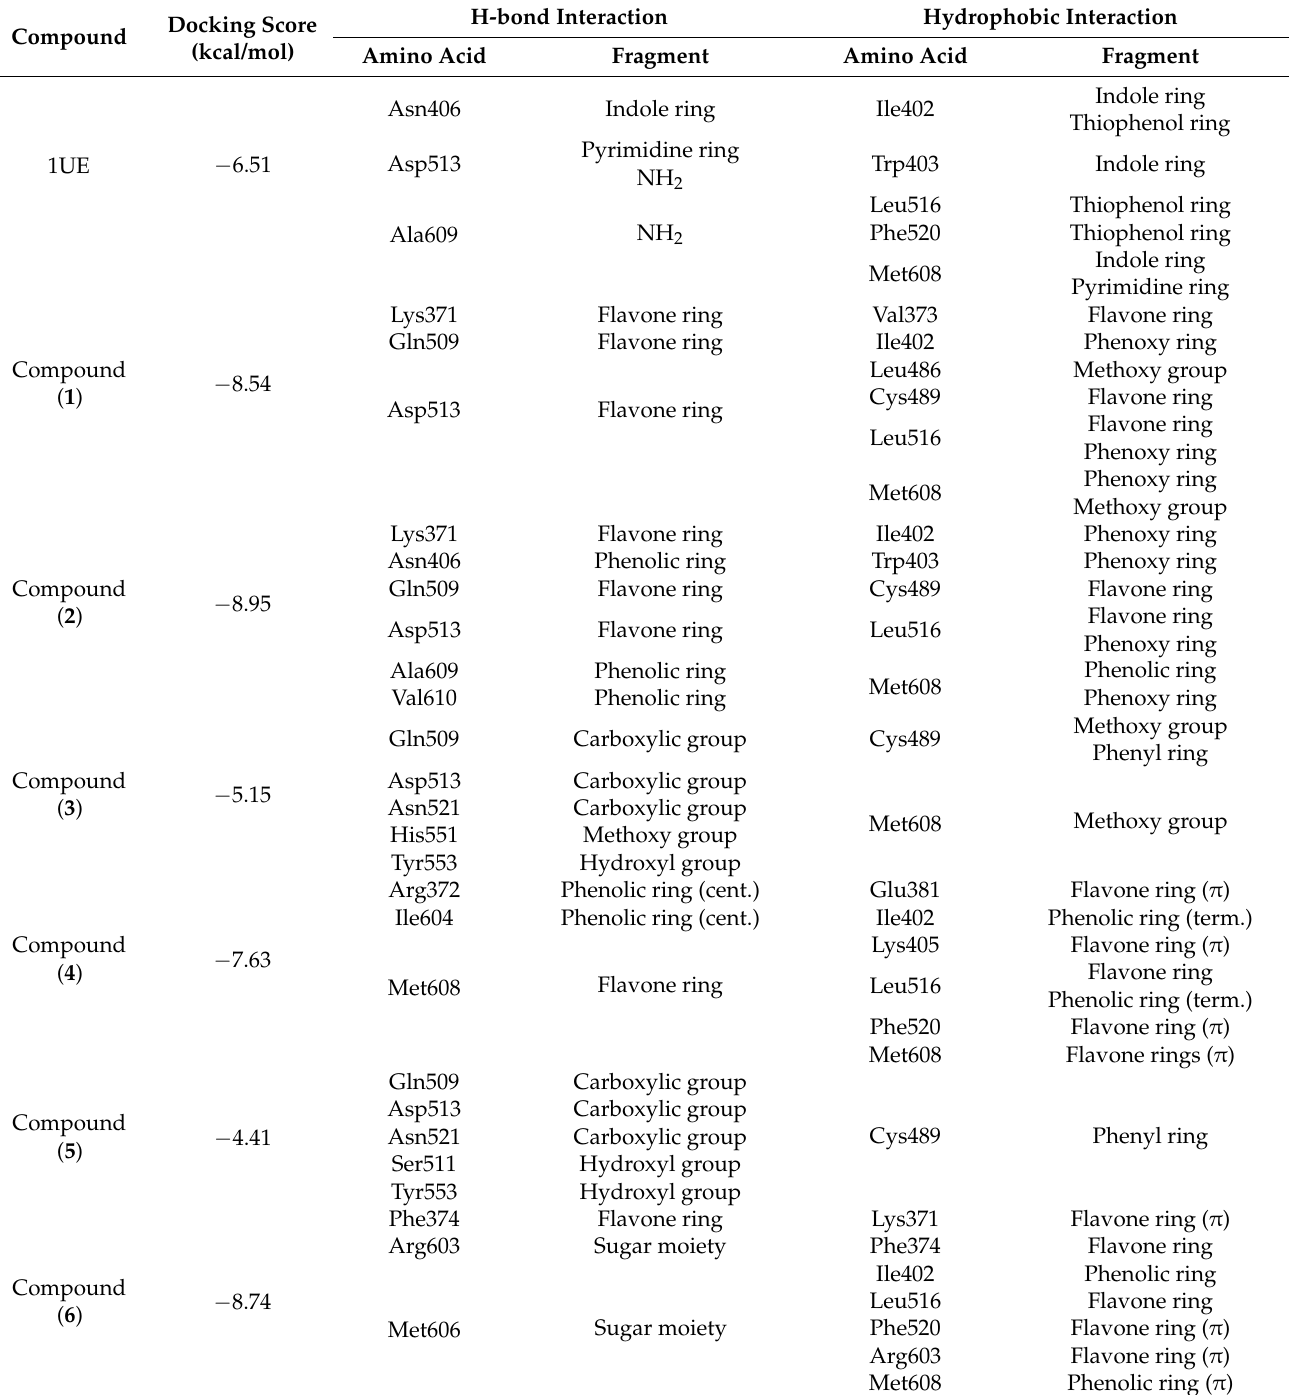
Table 1. Docking results, binding modes and interactions of pure compounds isolated from